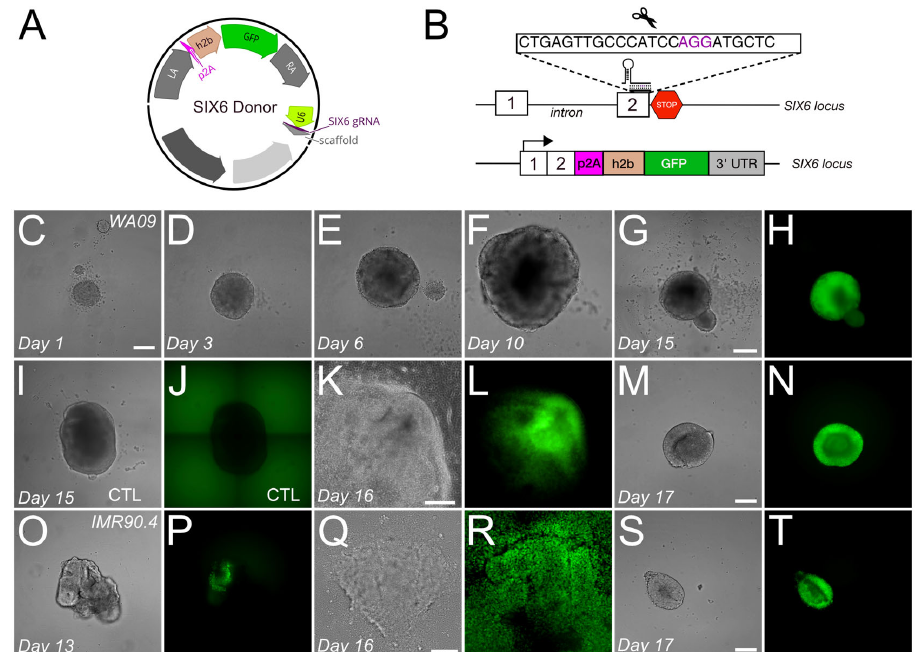
Figure 5. Targeting of the SIX6 gene in multiple genetic backgrounds and differentiation into 3D organoids. ( A ) A SIX6 hybrid donor vector with homology arms flanking the SIX6 stop codon and a U6 promoter for guide RNA targeting. ( B ) A schematic of SIX6-GFP integration at the SIX6 stop codon. ( C – G ) Brightfield images from days 1–15 organoids in WA09-HF-iCas9 SIX6-GFP ESCs with ( H ) fluorescence detected on day 15. ( I , J ) SIX6-GFP negative control organoids from WA09-HF-iCas9 SIX6- GFP ESCs in brightfield and GFP fluorescence. ( K , L ) WA09-HF-iCas9 SIX6-GFP organoids derived